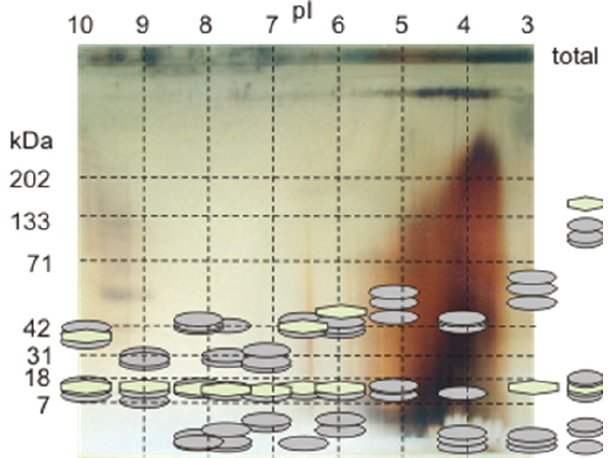
Figure 7. Comparison of a 2D-electrophoresis gel and molecular weights as determined using HPLC (oval: UV detection, polygon: refractometric